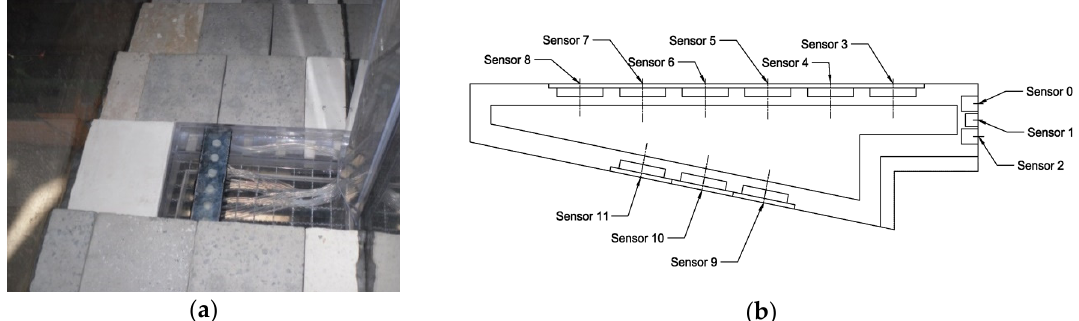
Figure 4. The measuring methacrylate WSB ( a ) and a block section with the locations of pressure sensors indicated ( b ) [28].